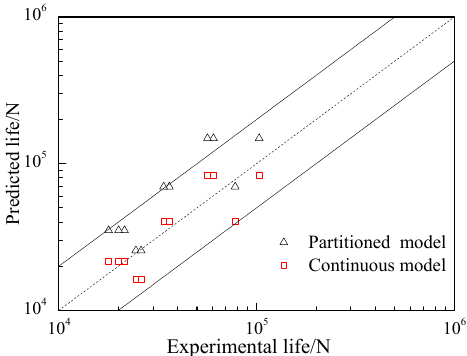
Figure 15. Life prediction of joint based on continuous and partitioned performance joint models.